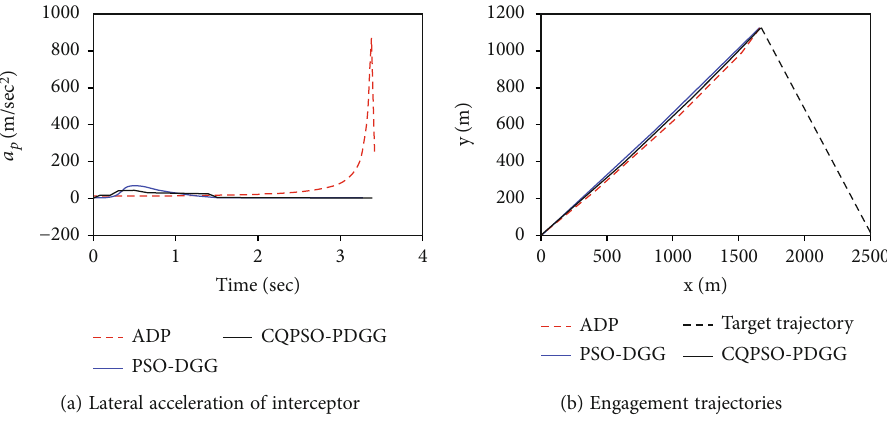
Figure 11: Comparison with ADP and PSO-DGG.